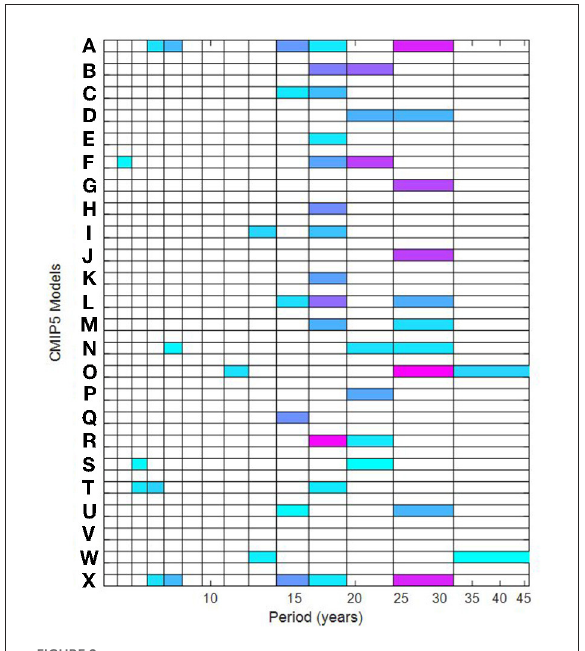
FIGURE2 Power spectrum density (PSD) of the 11-year running mean lag correlation between STIO SSTA in fall and Niño3.4 SSTA in the next fall in HadISST and CMIP5 simulations. Only PSD above the 95% significance level are shaded. Index (A–X) refers to different CMIP5 model as listed in Supplementary Table